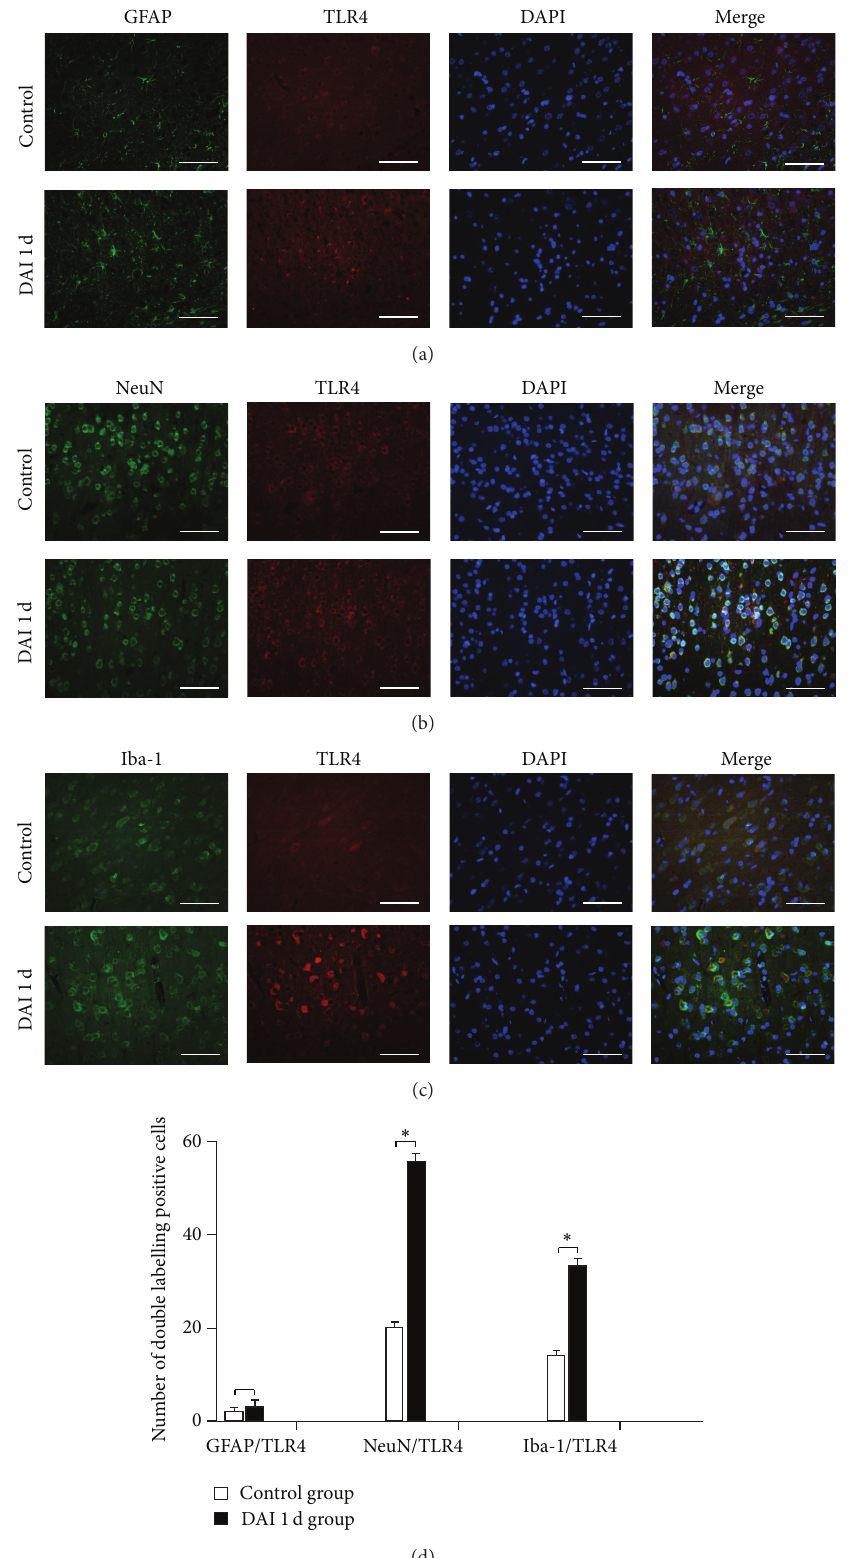
Figure 3: Localization of TLR4 in different cell types after DAI. (a–c) Double immunofluorescence staining was performed with an antibody to TLR2and antibodies toGFAP (markerforastrocytes), NeuN (marker forneurons),and Iba-1(marker formicroglia). Antibody binding was demonstrated using the following fluorophore-conjugated secondary antibodies: TLR4 (red), NeuN (green), GFAP (green), and Iba1 (green). Nuclei were stained with DAPI (blue). Scale bar = 50 𝜇 m. (d) The bar graphs show the results for the numbers of TLR4- and NeuN/GFAP/Iba- 1-positive cells in the control and DAI 1d groups. Values are presented as the mean ± SD ( 𝑛 = 3 ; ∗ 𝑝 < 0.05